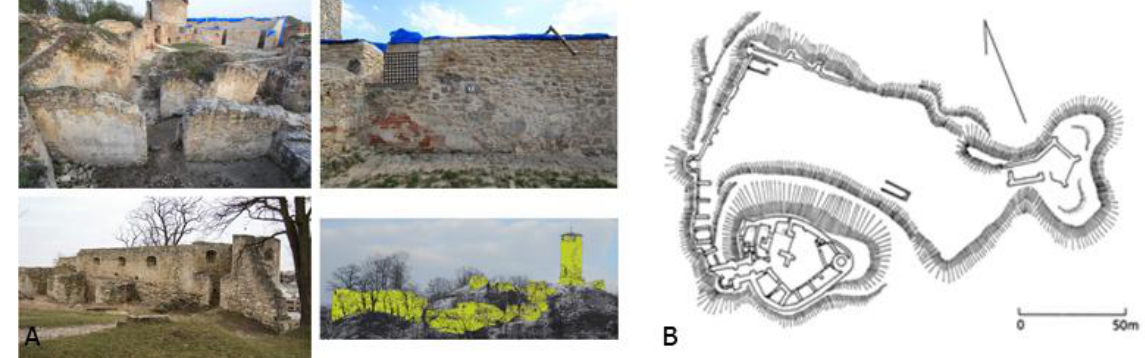
Fig. 1 A sketch of the ruins of the castle in Iłża (source: A) Own source, B) Regional Museum in Iłża)